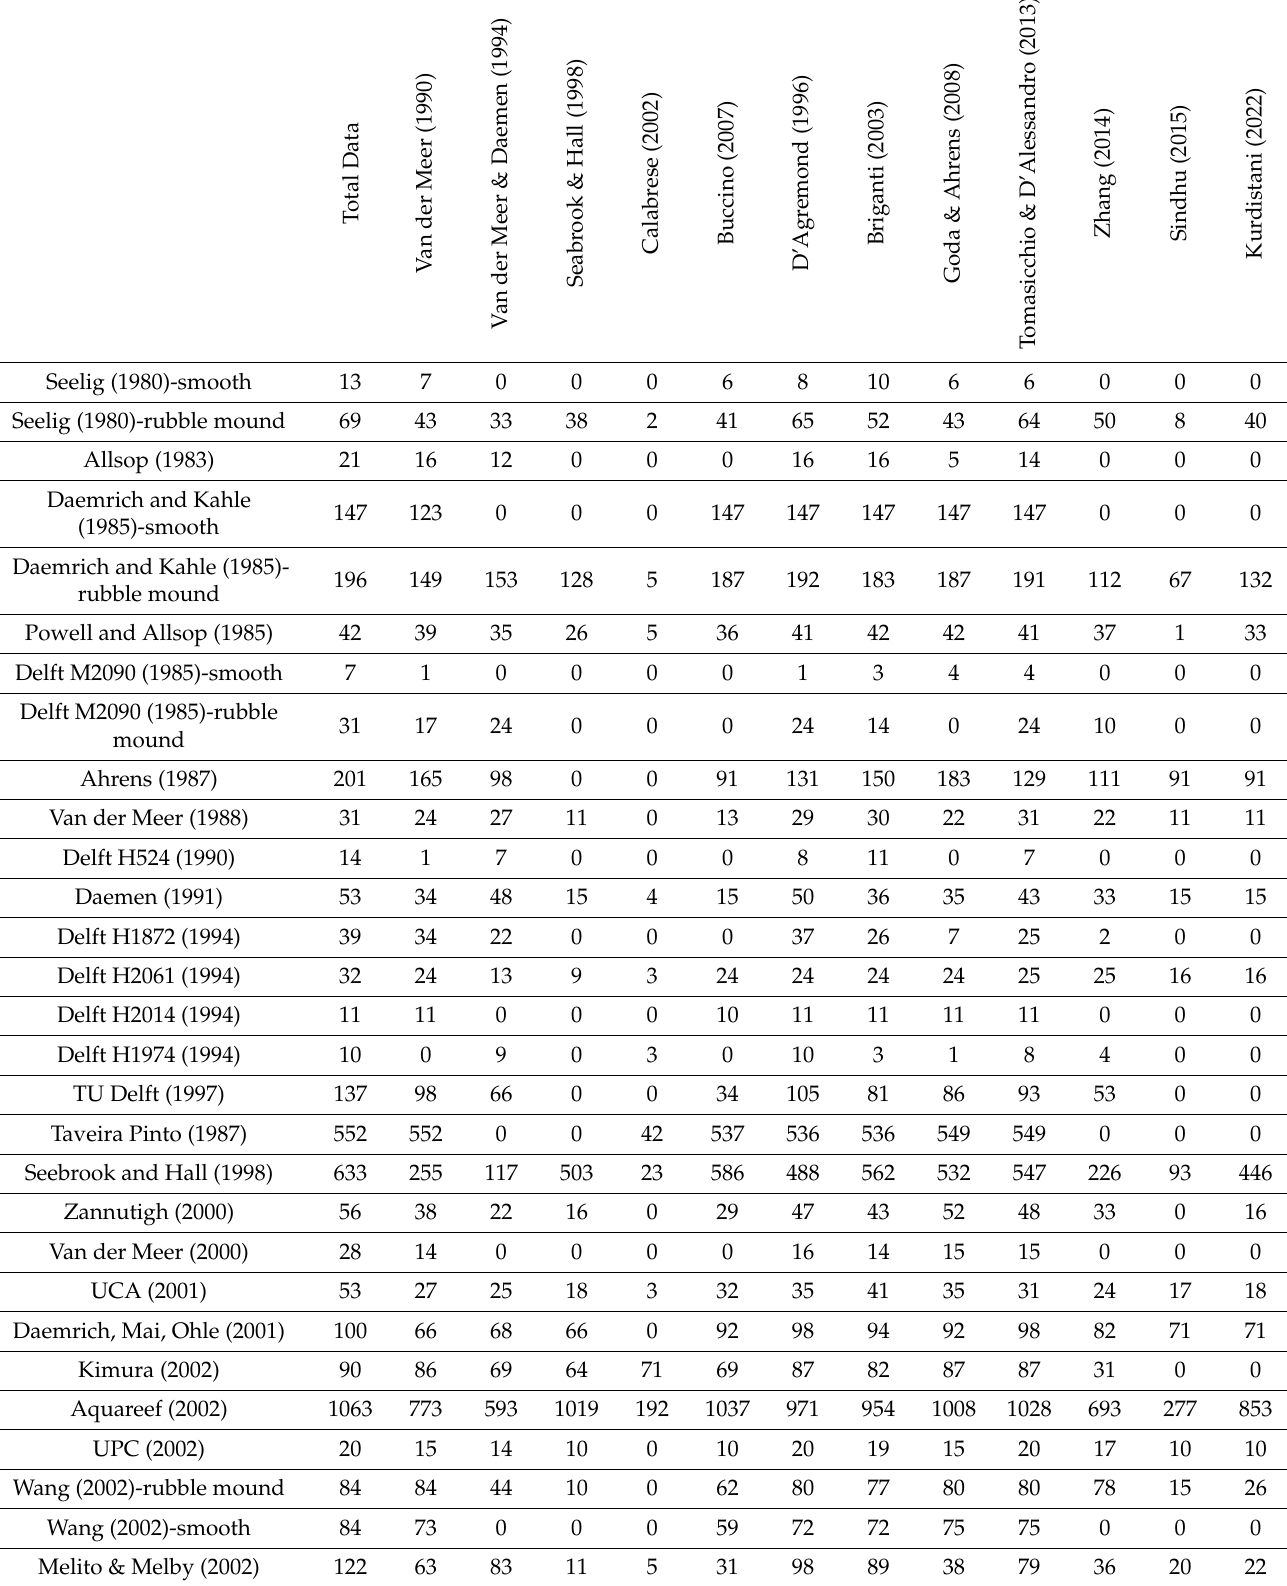
Table 5. Number and percentage of calculated data K t,cal in the interval ± 50% respect to K t,obs